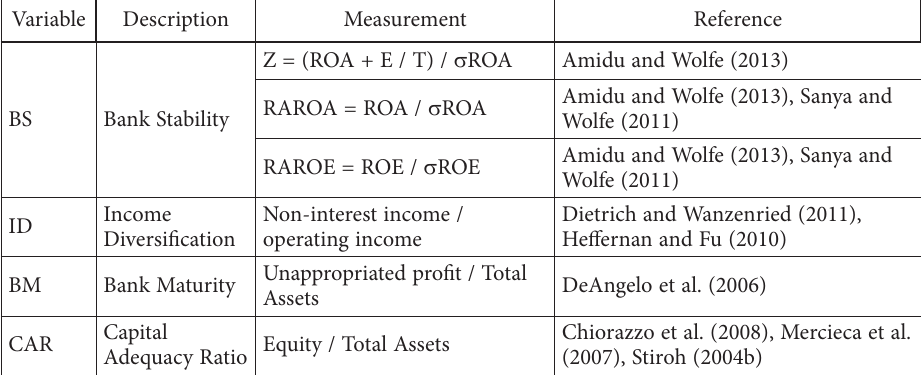
Table 2. Variables measurement (source: self-reported)